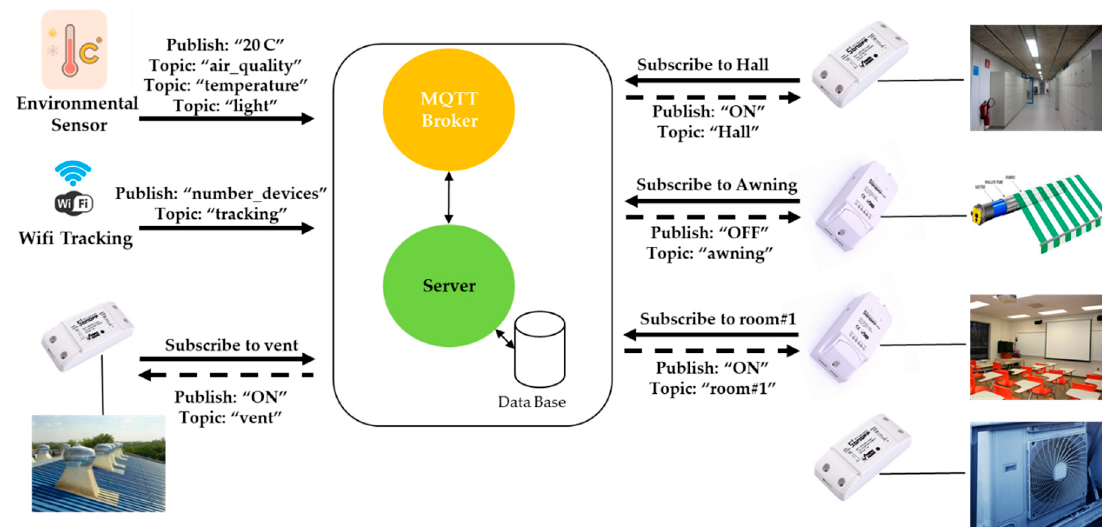
Figure 12. Example of MQTT Interactions .